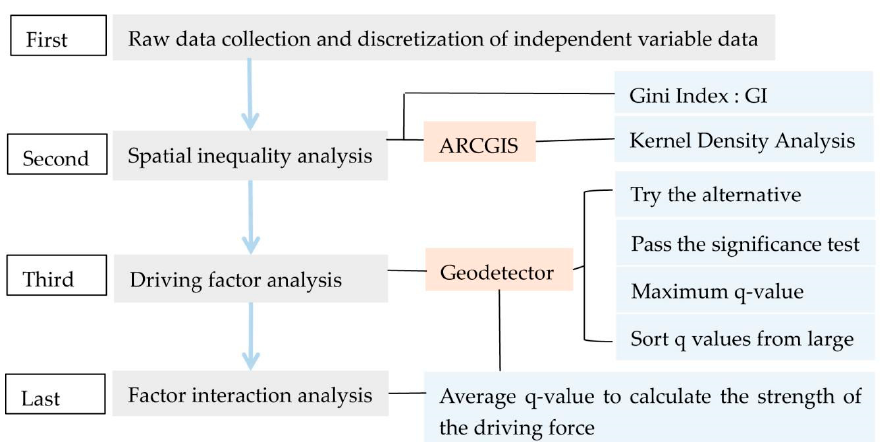
Figure 2. The technical flowchart of this study.